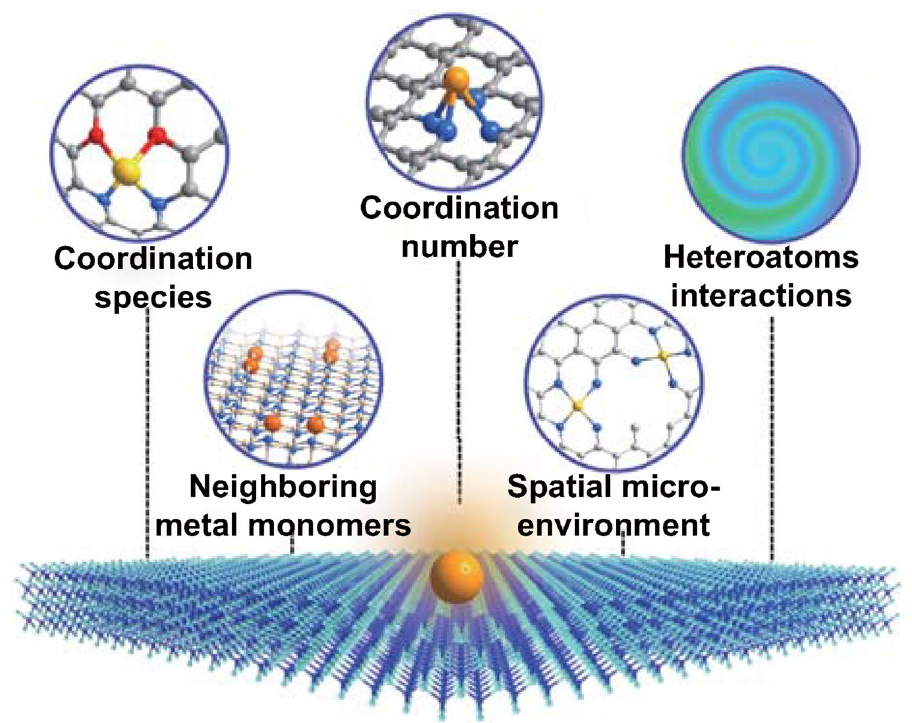
Fig. 1 Schematic illustration of the strategies to engineer coordination sphere of isolated active